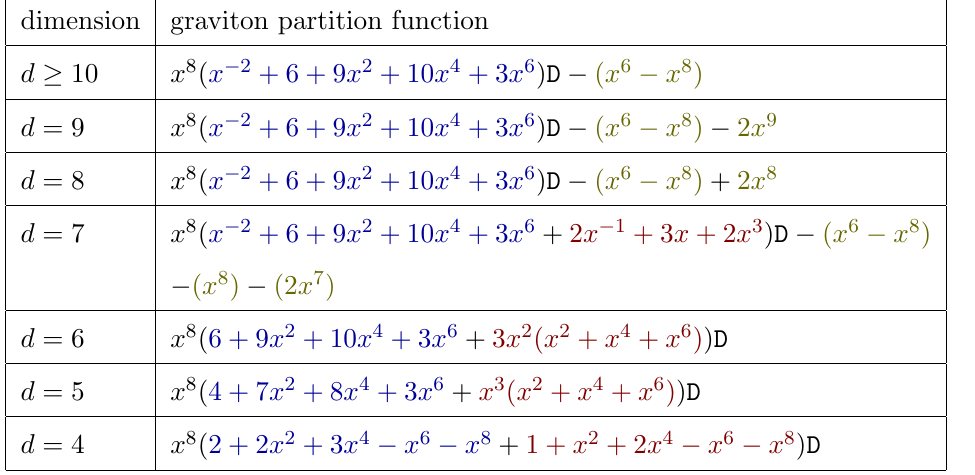
Table 7 . Partition function over the space of Lagrangians involving four R (cid:22)(cid:23)(cid:26)(cid:27) ’s (no R (cid:22)(cid:23) , no R ). This includes both parity even and parity odd